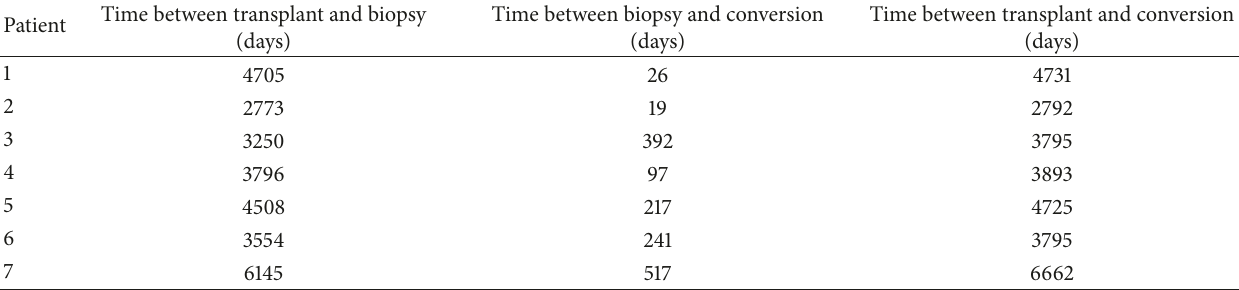
Table 2: Time between transplant and biopsy, biopsy and conversion, and transplant and